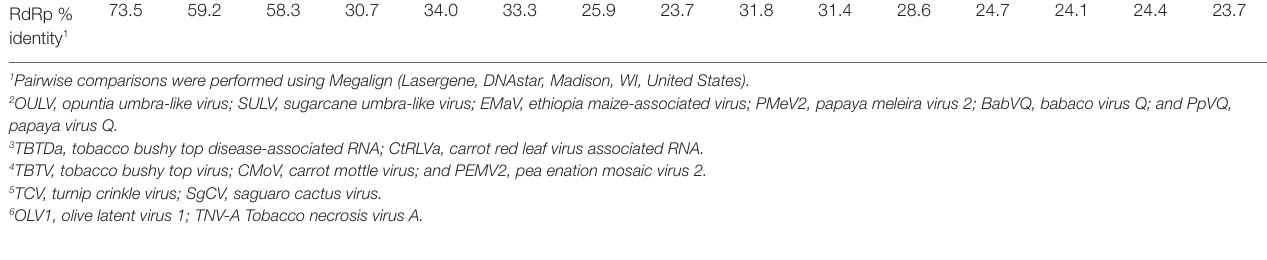
TABLE 2 | RNA-seq and VirFind identification of graft-transmissible virus and viroids of citrus associated with citrus plants expressing yellow vein symptoms. Sample 1